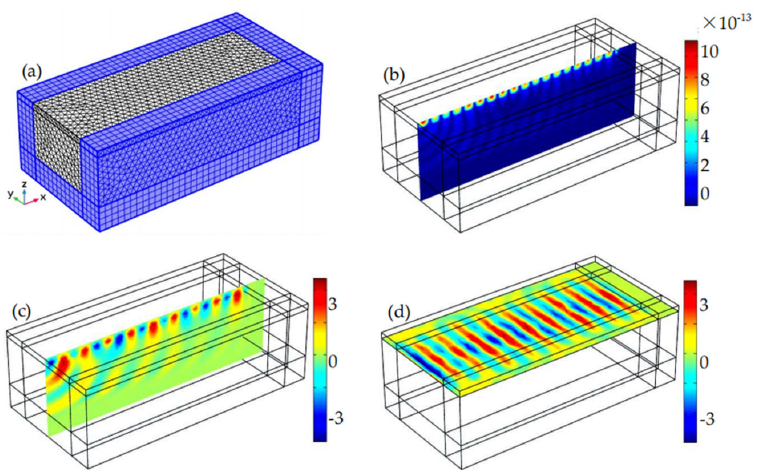
Figure 4. The finite element model ( a ), the displacement component u y in the x - z plane ( b ), the horizontal shear stress σ zy in the x - z plane ( c ), and the horizontal shear stress σ zy at the interface ( d ) at 130 kHz as the frost coating thickness on the aluminum substrate is 5 mm.